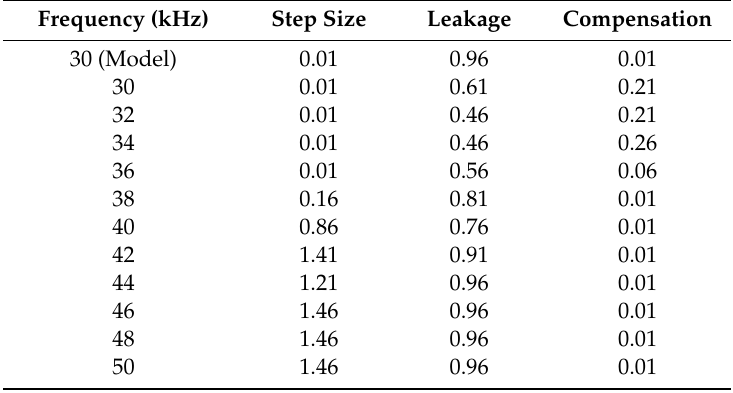
Table A3. Used parameters in the